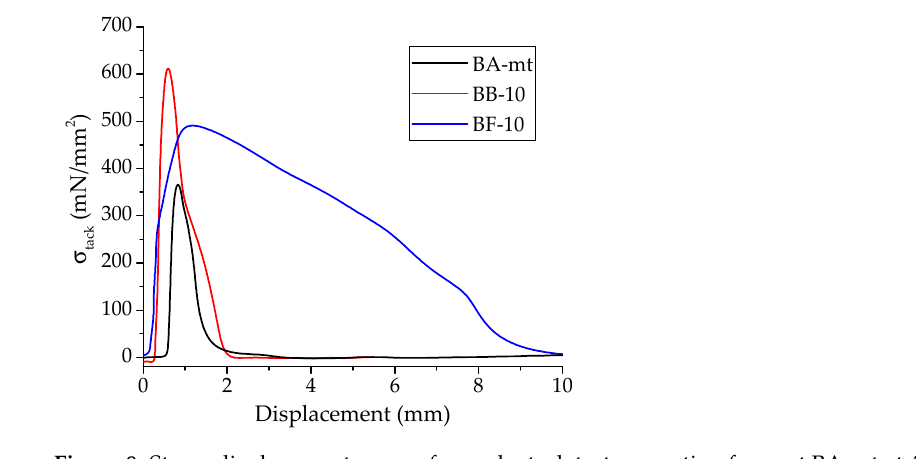
Figure 8. Stress-displacement curves for probe tack test separation for neat BA-mt at 45 °C, BB-10 and BF-10 at 25 ° C.